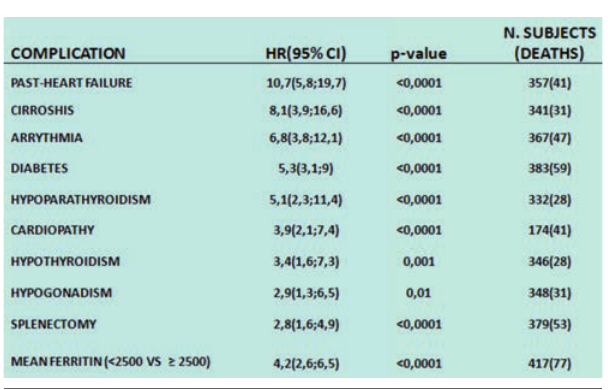
Figure 2. Cardiac disease-free survival corresponding to different percentages of serum ferritin levels exceeding 2500 ng/ml (Olivieri et al .,1994).